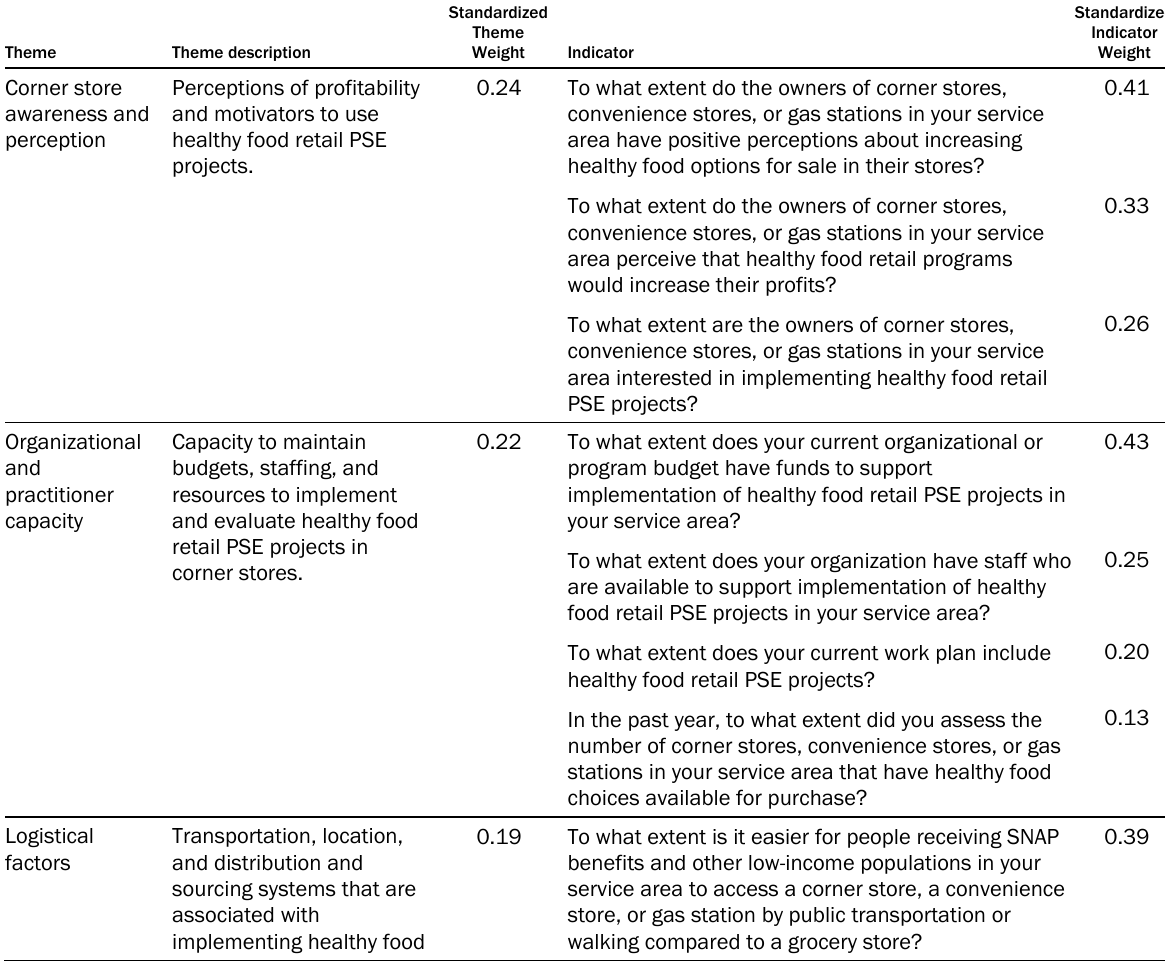
Table 1. Final Themes and Indicators for HFR Interventions Based on Indicator and Theme Ranking Exercises Conducted with the Expert Panel and Refinement by the Research